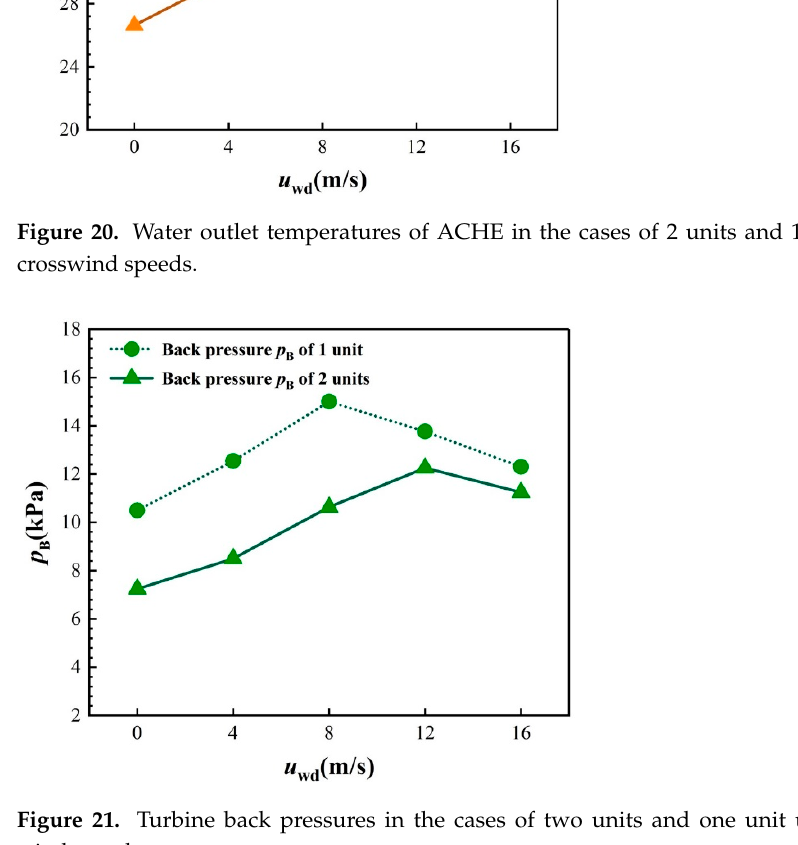
Figure 21. Turbine back pressures in the cases of two units and one unit under typical crosswind speeds.